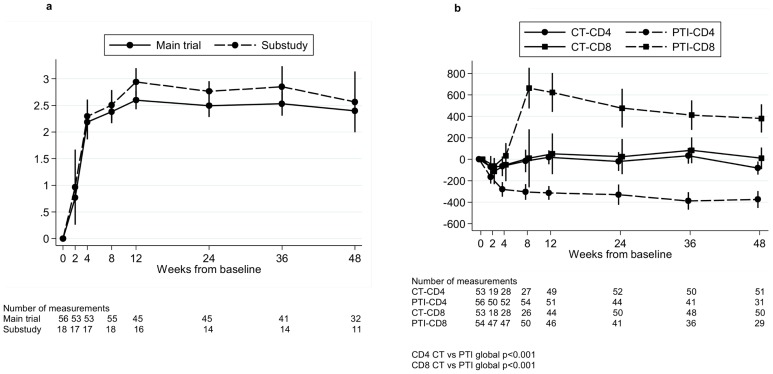
Change in HIV-1 RNA, CD4 and CD8 cells from baseline in the PTI group.Change in HIV-1 RNA from baseline for all children in the trial in the PTI (planned treatment interruption) group off ART (antiretroviral therapy) and children in the substudy in the PTI group off ART (a). Change in CD4 and CD8 from baseline for all children in the trial in the PTI (planned treatment interruption) group off ART (antiretroviral therapy) and in the CT (continuous ART) group (b). Changes from baseline were estimated using normal regression of actual measurements adjusting for baseline using the overall mean at randomisation as the reference category.